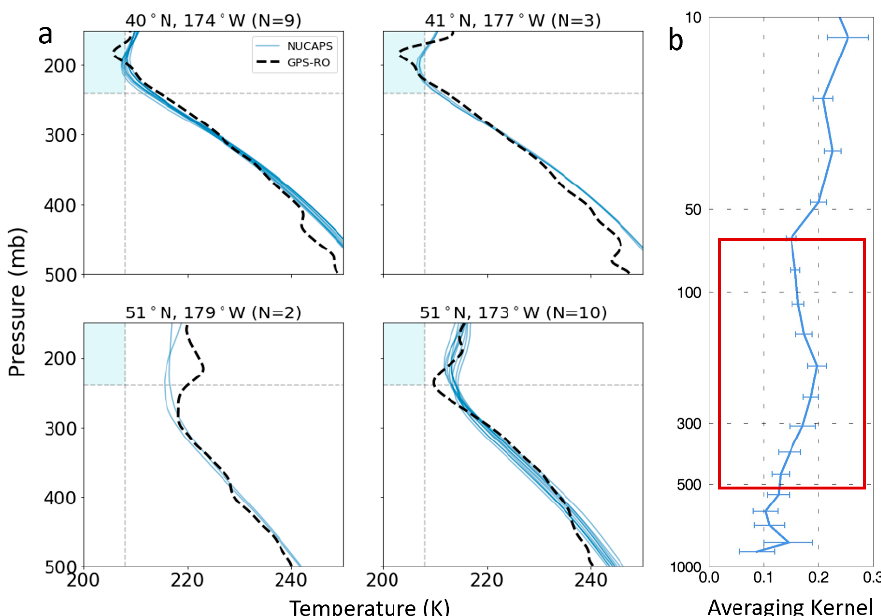
Figure 4. ( a ) NUCAPS profiles showing the matchups between COSMIC (black dashed line) and NUCAPS (blue solid lines), where the shaded blue box indicates the temperature and pressure criteria for CAA. The profile locations are annotated in Figure 3. ( b ) The mean (solid line) and standard deviation (error bars) of the averaging kernel matrix (AKM) diagonal vectors are a function of pressure in the study domain on 26 February 2018.